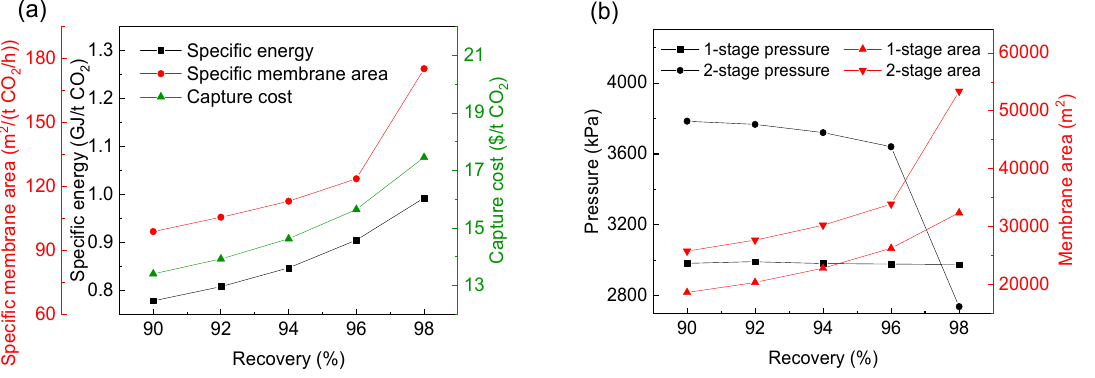
Figure 8. Effect of increasing CO 2 recovery on the performance index and the best operating param- eters of the optimal process using the commercial membrane in Table 2. ( a ) The CO 2 capture cost, specific power consumption and membrane area; ( b ) optimal pressure and area of each membrane.